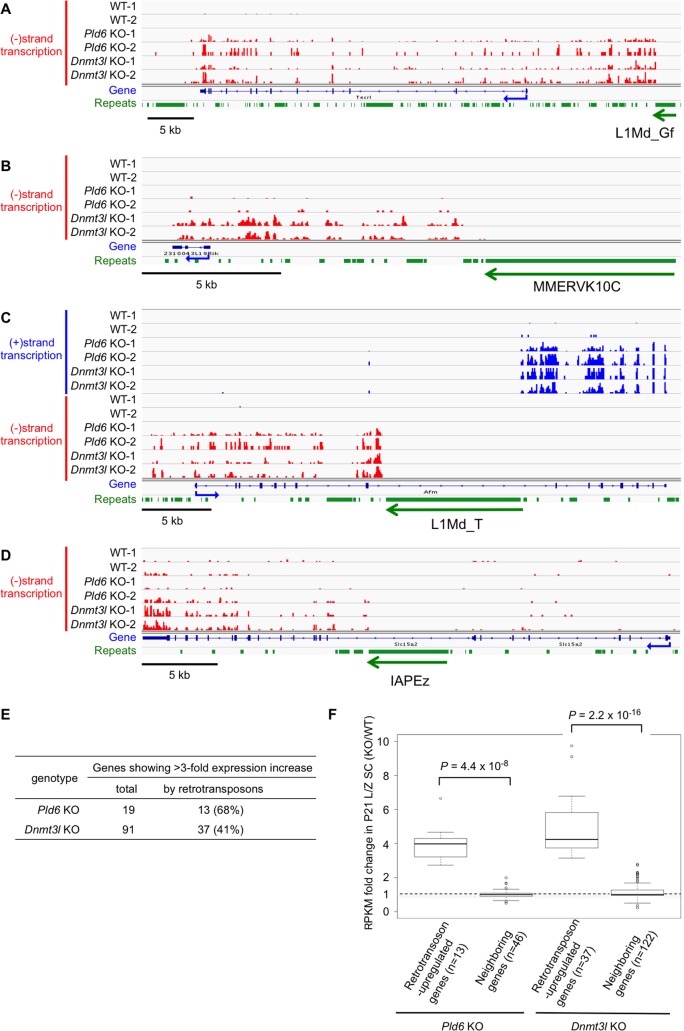
Retrotransposons induce neighboring genes in Pld6 KO and Dnmt3l KO spermatocytes.(A–D) Integrative Genomics Viewer screenshots are shown for Tecrl driven by an upstream L1Md_Gf copy (A), 2310043L19Rik driven by an upstream MMERVK10C copy (B), Caps2 driven by an intronic (antisense) L1Md_T copy (C), and Slc15a2 driven by an intronic IAP (D). The y-axis shows the read density: the upper limit corresponds to 1.0 RPM (reads at each nucleotide position per million mapped reads) in all panels. Reads representing plus-strand (blue) and minus-strand (red) transcripts are shown separately. Reads matching repeat regions are removed because of the uncertainty in their origin. KO-1 and -2 and WT-1 and -2 indicate biological replicates. The orientation of the retrotransposon affecting the gene is indicated at the bottom of each panel. (E) Number of genes with a >3-fold increase in expression in Pld6 KO and Dnmt3l KO. See supplementary S3 and S4 Tables for the list of these genes. (F) Expression of retrotransposon-driven genes and neighboring genes (within 100 kb) in Pld6 and Dnmt3l KO spermatocytes. P values determined using the U test are shown.